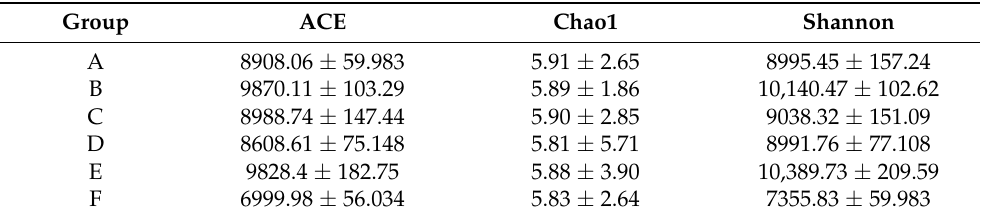
Table 2. Effect of corn and wheat diet supplemented with flaxseed and enzymes on alpha diversity estimation of the 16S gene libraries of cecal samples from the 16S sequences in laying birds.